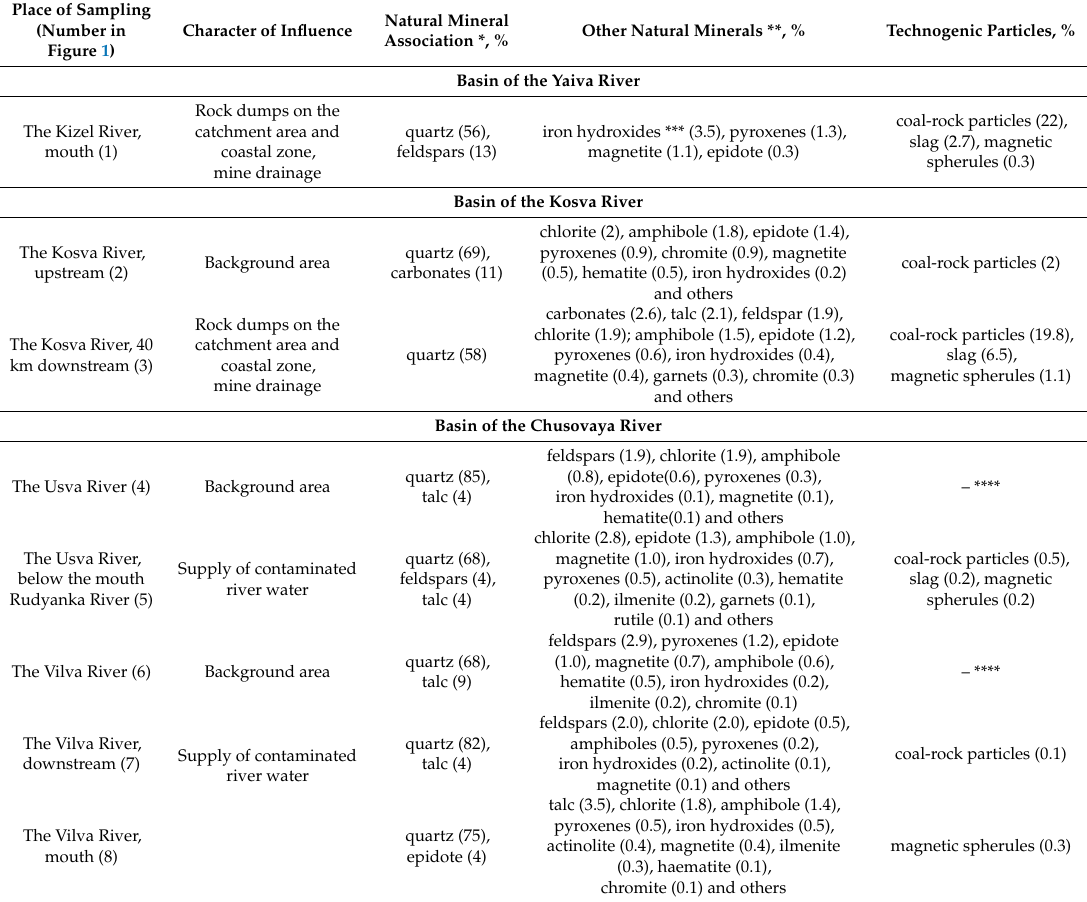
Table 1. Mineral composition of sandy and sandy-gravel sediments in the